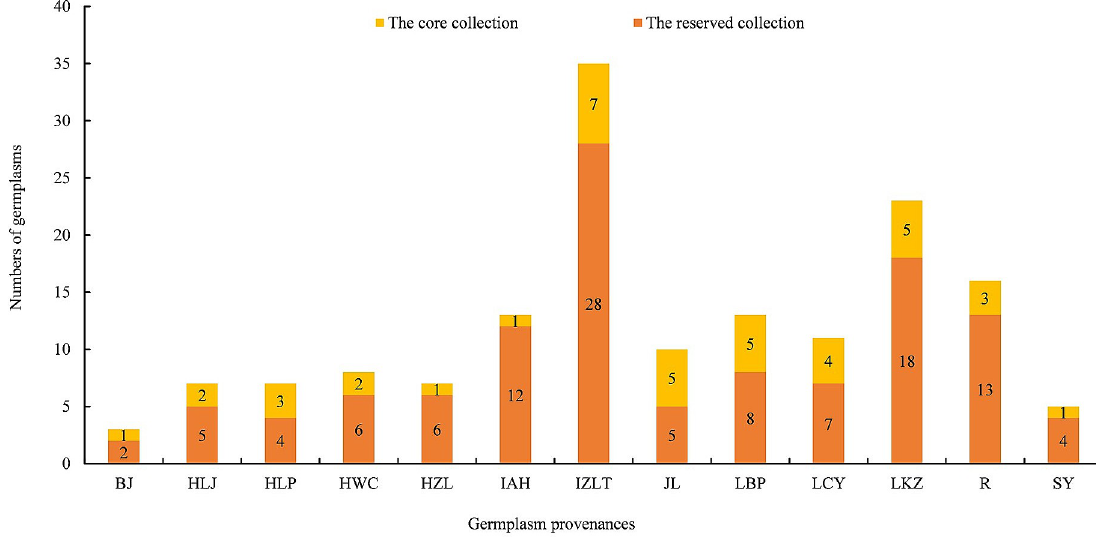
Fig 3. Numbers of core collection and reserved collection of each provenance. The numbers of core collection (yellow) plus the numbers of reserved collection (orange) were equal to the numbers of initial collection. BJ: Beijing; HLJ: Heilongjiang; HLP: Luanping, Hebei; HWC: Weichang, Hebei; HZL: Zhuolu, Hebei; IAH: Aohan, Inner Mongolia; IZLT: Zhalantun, Inner Mongolia; JL: Jilin; LBP: Beipiao, Liaoning; LCY: Chaoyang, Liaoning; LKZ: Kazuo, Liaoning; R: Russia; SY: Yuxian,